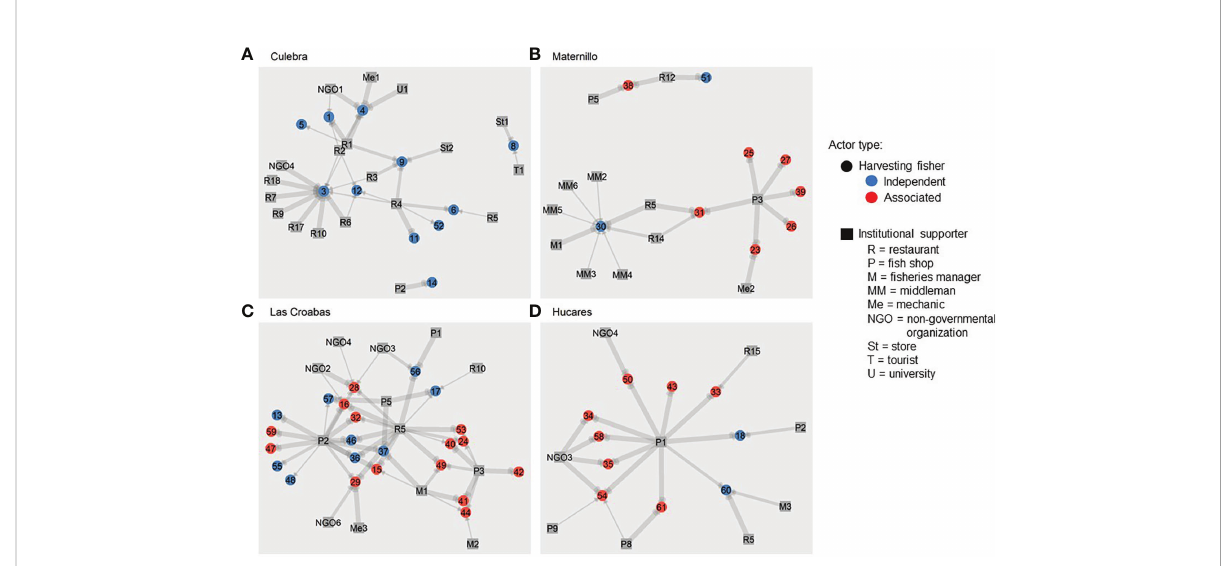
FIGURE 4 Support for work across the supply chain received by harvesting fi shers from institutional actors. Support for work across the supply chain received by harvesting fi shers from institutional actors (e.g. buyers, managers, gear suppliers, and non-governmental organizations), across landing sites of Culebra (CUL; panel A ), Maternillo (MAT; panel B ), Las Croabas (CRO; panel C ), and Hu ́ cares (HUC; panel D ). The network reveals differences in the type and quantity of supporters among self-governance arrangements. This network excludes ties among fi shers and ties among institutional actors, and therefore it is a bipartite (i.e., two-mode) network. Tie width denotes the value placed by fi shers on the support from that actor (Little, Moderate, A lot), with higher value ties represented by thicker lines. Node colors for fi shers (circles) highlight whether their self-governance arrangement (i.e., associated, or independent), while institutional actors are represented by squares. The letter R denotes restaurants, the letter M denotes managers, while MM denotes middlemen. The letter P represents fi sh shops, including those run by Associations P1, P2, and P3. The acronym “ Me ” represents mechanics, while “ St ” represents hardware and fuel stores. Isolate fi shers (those that did not report institutional support) were eliminated for